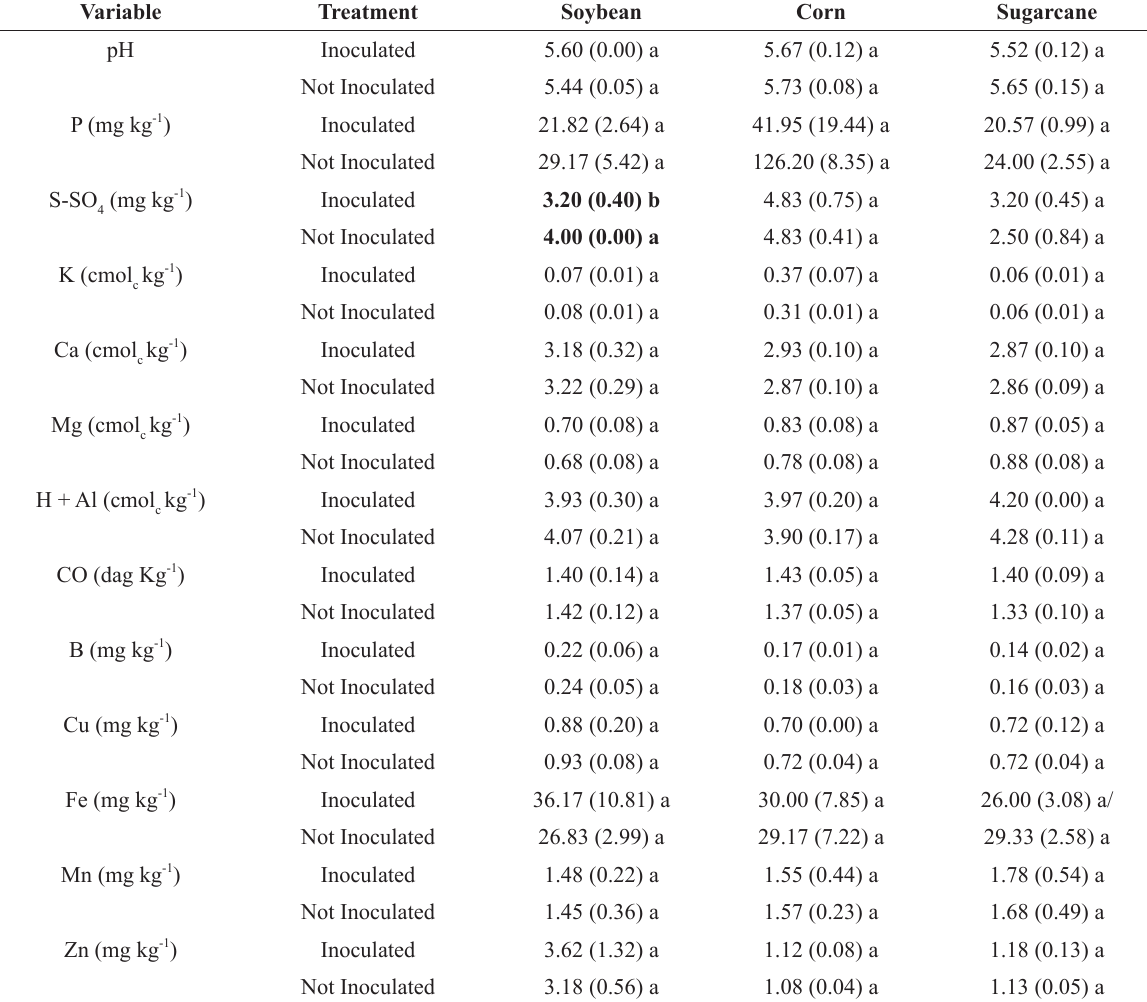
Fertility attributes of soil under soybean, corn, and sugarcane inoculated or uninoculated with the fungal solution composed of the fungi Beauveria bassiana, Metarhizium anisopliae., Pochonia chalamydosporia, Purpureocillium lilacinum, and Trichoderma asperella